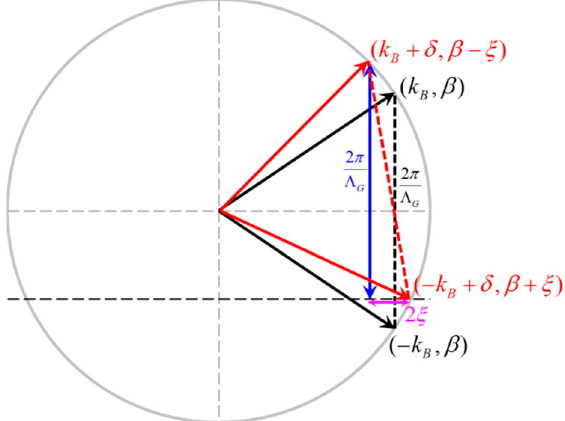
Figure A1. Wavevector representation illustrating phase mismatching of the incident and reflected waves in the single-grating EOPBD with a grating period of Λ G . The annotation in black shows the perfect phase matching under the Bragg condition. The annotation in red reveals the quantity of phase mismatch when the incident wave is slightly deviated from the Bragg condition.